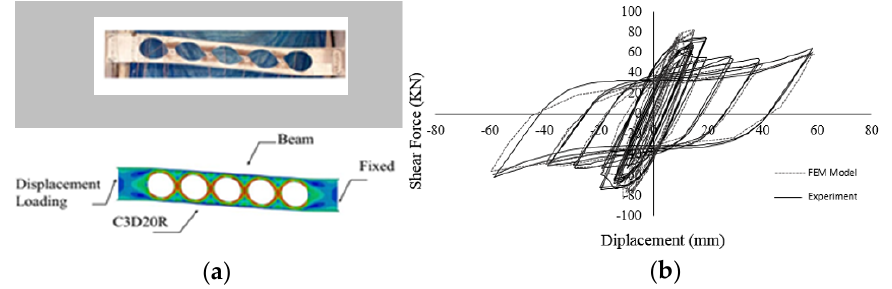
Figure 16. Verification of the second finite laboratory test ( a ) Test specimen and computational model ( b ) Load vs. deformation hysteretic response.